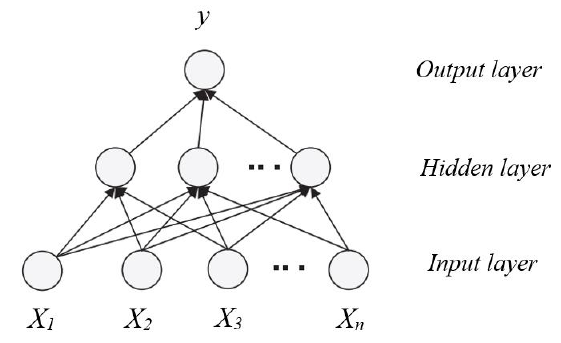
Figure 3. A structure of a three-layer feedforward neural